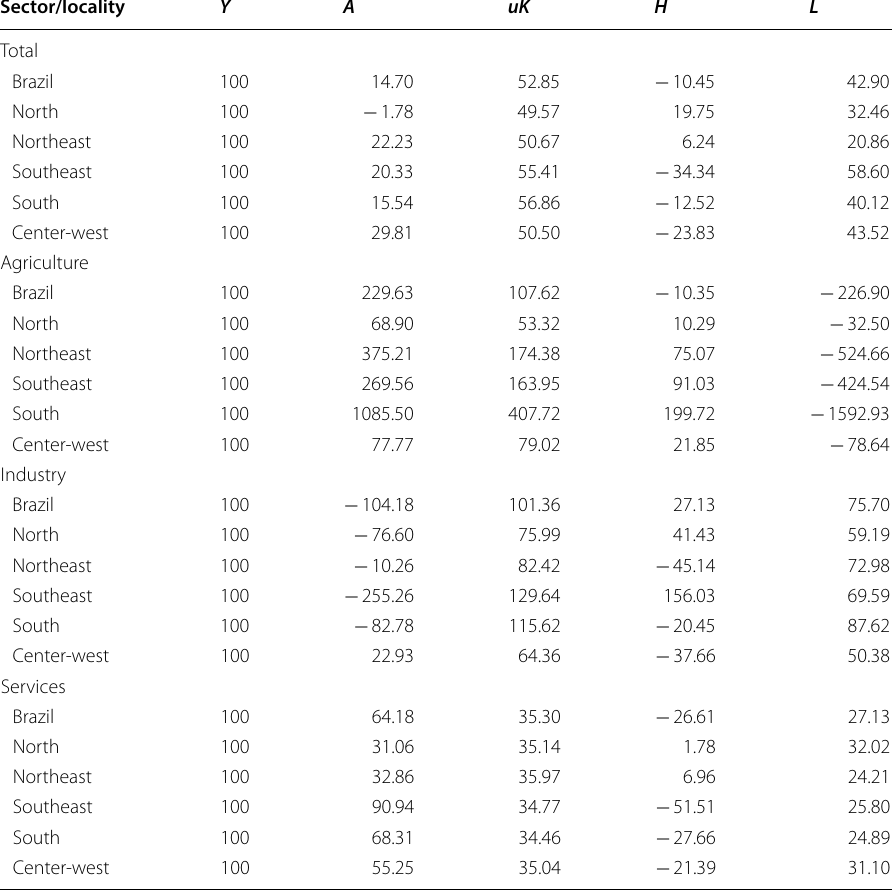
The results are the percentage contributions of each factor input to economic growth, ratio between growth of the factor of production and production